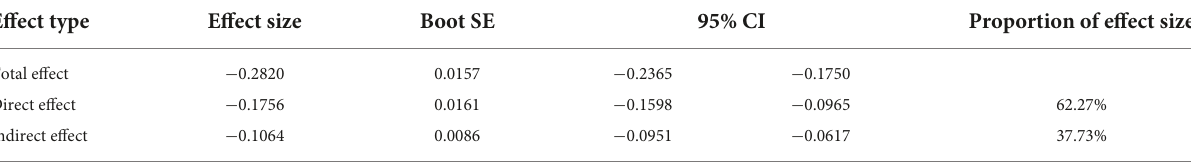
TABLE 4 The mediating role of self-control in the relationship between perceived social support and